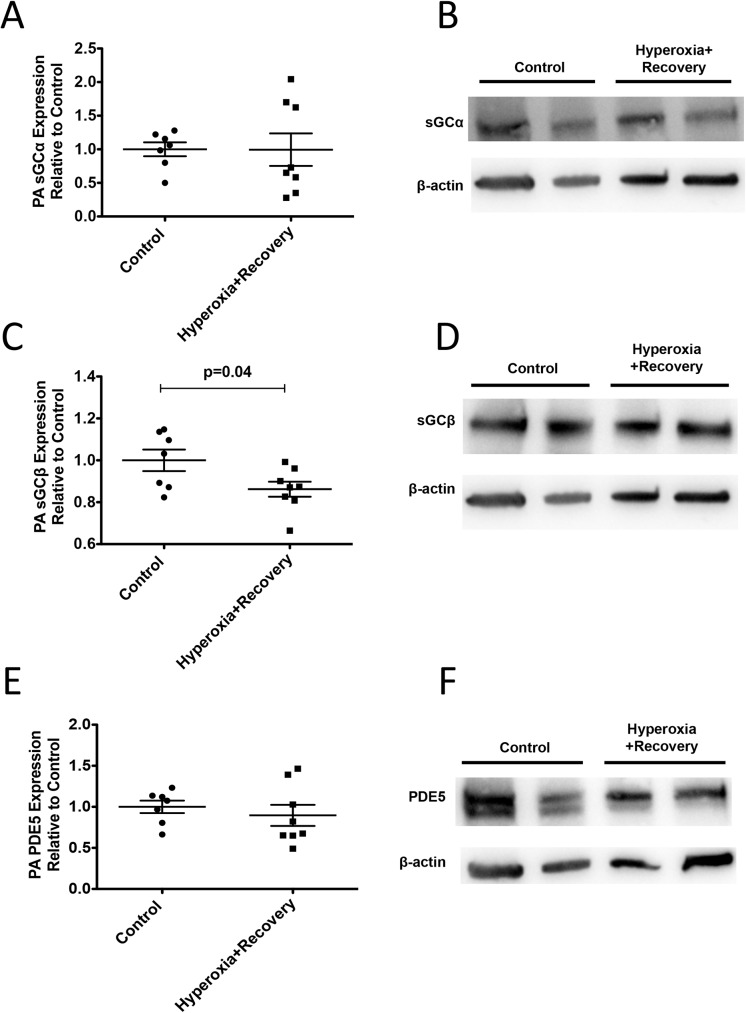
PA sGCβ expression is persistently decreased after neonatal hyperoxia exposure.Mice were exposed to hyperoxia or room air for 14d, followed by recovery in room air for an additional 7d (21d). PA protein expression of sGCα (A), sGCβ (C), and PDE5 (E) were measured by western blot and normalized to β-actin (n = 7–8 animals per group). Representative Western blots are shown for sGCα (B), sGCβ (D), PDE5 (F), and corresponding β-actin. Data are shown as fold changes relative to untreated controls and are expressed as dot plots with each dot representing individual animals with means and SEM represented by horizontal lines. Results were analyzed using an unpaired t-test.